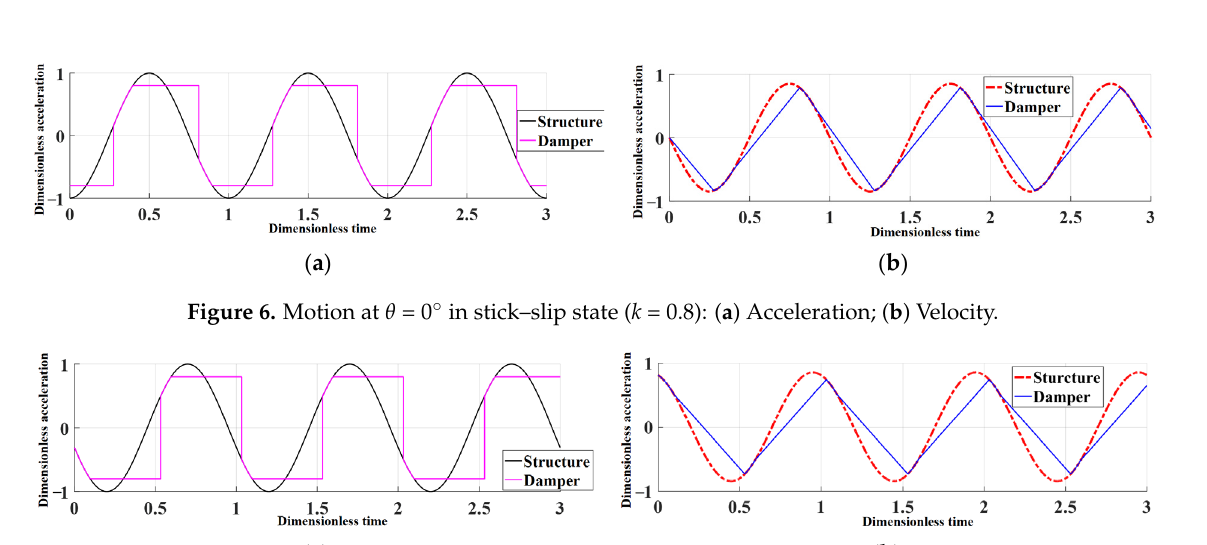
Figure 5. Schema of motion of structure with 6 ND at t = 0 (two positions).